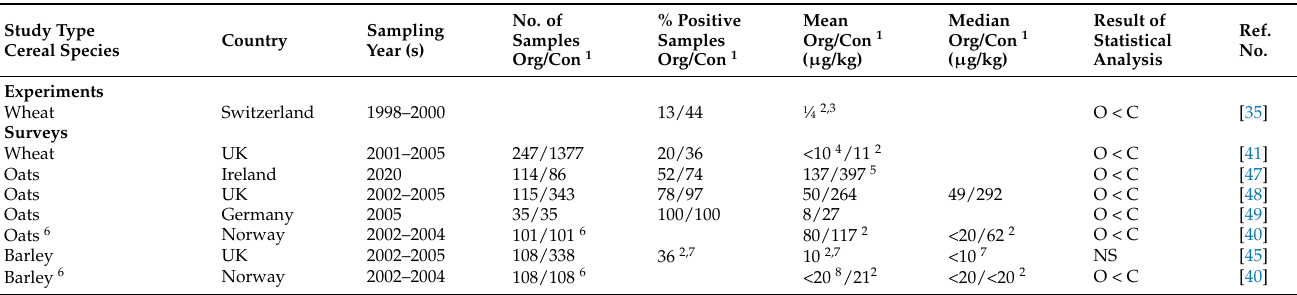
Table 3. Results from field-experiment- and farm-survey-based studies that compared the sum of T-2 and HT-2 toxin (T-2/HT-2) concentrations in organically (org) and conventionally (con) produced cereal